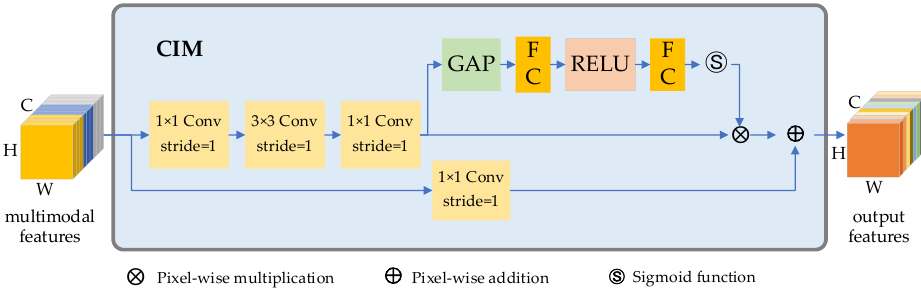
Figure 9. Channel interaction module.